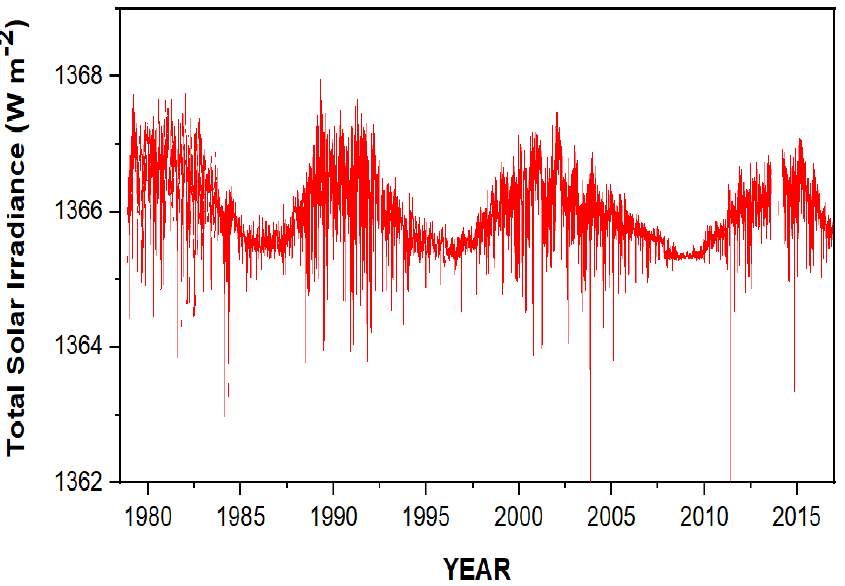
Figure 11. Solar irradiance variations as recorded by a composite of satellite sensors for the period 1978 to 2018. (Available online: lasp.colorado.edu/) (accessed on 10 March 2020). 1978 to 2018. (Available online: lasp.colorado.edu/) (accessed on 10 March